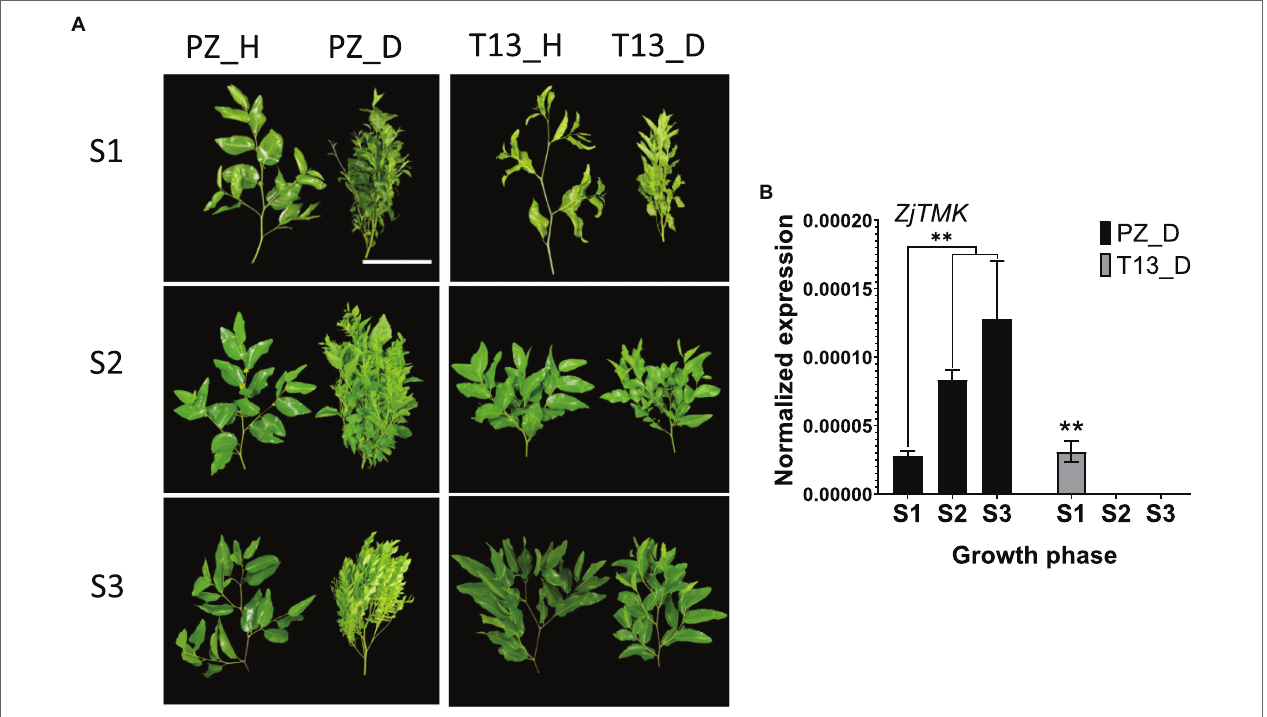
FIGURE 1 | Phenotypes and expression of ZjTMK in “PZ” and “T13” shoots infected by phytoplasma. (A) Shoot phenotypes at three growth phases (S1, S2, and S3) of Ziziphus jujuba Mill. “Pozao” and “T13.” White bars are 10 cm. (B) The normalized expression level of ZjTMK in diseased Ziziphus jujuba Mill. “Pozao” and “T13” at three growth phases (S1, S2, and S3) in three independent replications, and the error bar represents the SE. “PZ_D” and “T13_D” represent diseased Ziziphus jujuba Mill. “Pozao” and “T13.” “PZ_H” and “T13_H” represent healthy Ziziphus jujuba Mill. “Pozao” and “T13.” * p < 0.05; and ** p <